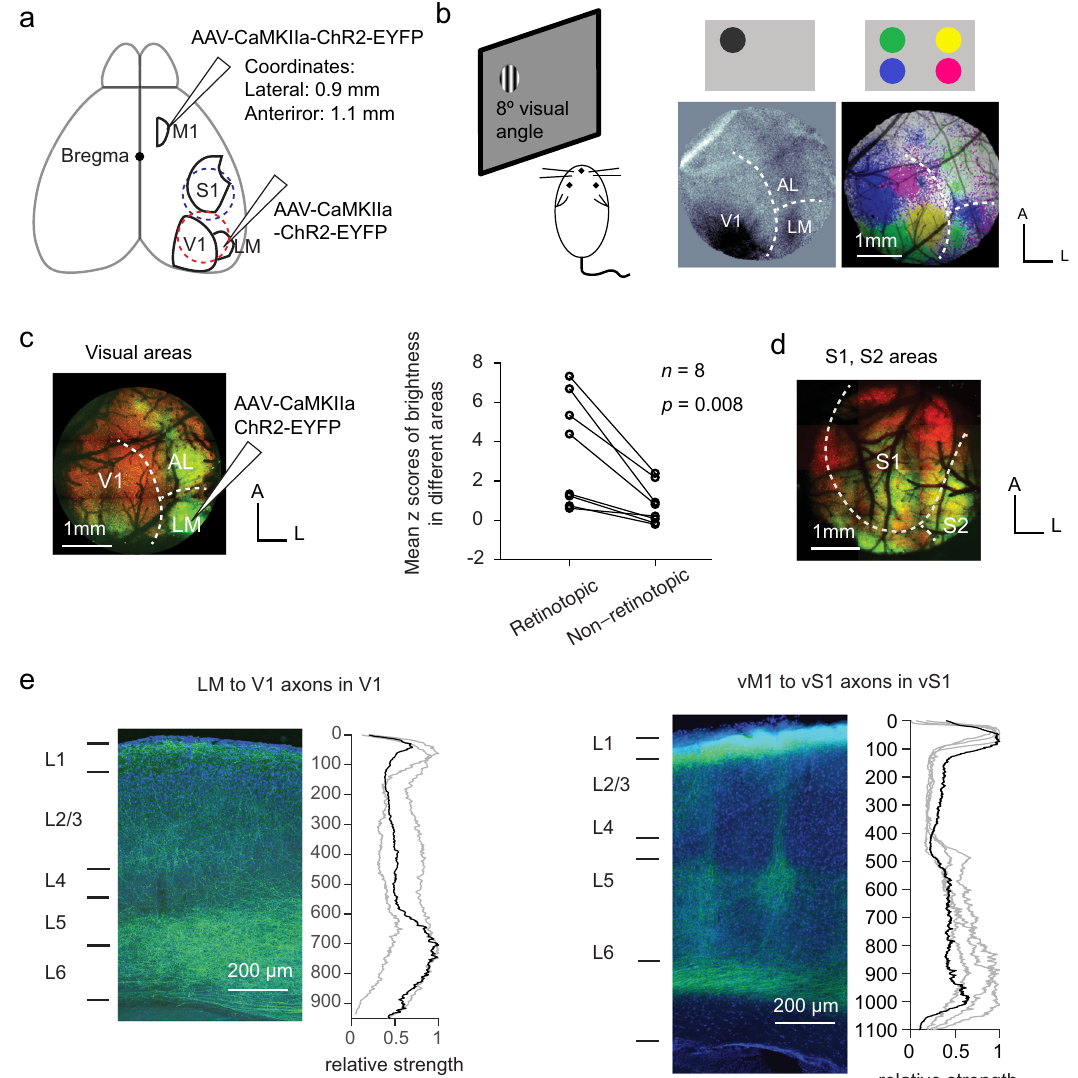
Fig. 1 | Feedback axon terminal distribution of the two feedback pathways. a AnatomyoftheareasV1,LM,vS1,andvM1.TheviruswasinjectedineithervM1or LM in different animals. Feedback axon terminals were labeled with ChR2-YFP in either V1 (red dashed circle) or S1 (blue dashed circle). b Intrinsic imaging to identify V1 and LM. Left: experimental paradigm. Grating stimuli drifting horizon- tally or vertically were shown to the left eye, on one of the four locations on the monitor. A CCD camera was used to record brain intrinsic activity from a cra- niotomy exposing visual areas of the right hemisphere. Middle: intrinsic imaging map of the stimulus in the top lateral corner. The white dashed lines mark the borders among V1, LM, and AL. Right: intrinsic imaging map of stimuli in all four locations. Different colors represent brain areas responsive to stimuli in different locations (green: top-lateral; yellow: top-medial; blue: bottom-lateral; magenta: bottom-medial). Scale bar: 1mm. c LM to V1 feedback projections target the reti- notopic corresponding area in V1. Left: EYFP expression of the animal in (b), with responses (either EPSC or EPSP) elicited in pyramidal cells, PV+ cells, and SOM+ cells in L2/3 were higher than those of their counterparts in L5 (Fig. 3b, c, for p values, refer to Supplementary Tables S1-S4). In contrast, in vS1, the responses of pyramidal cells and PV+ cells in L2/3 were lower than their counterparts in L5, but this was the opposite for SOM+ cells (Fig. 3b, c, for p values, refer to Supplementary